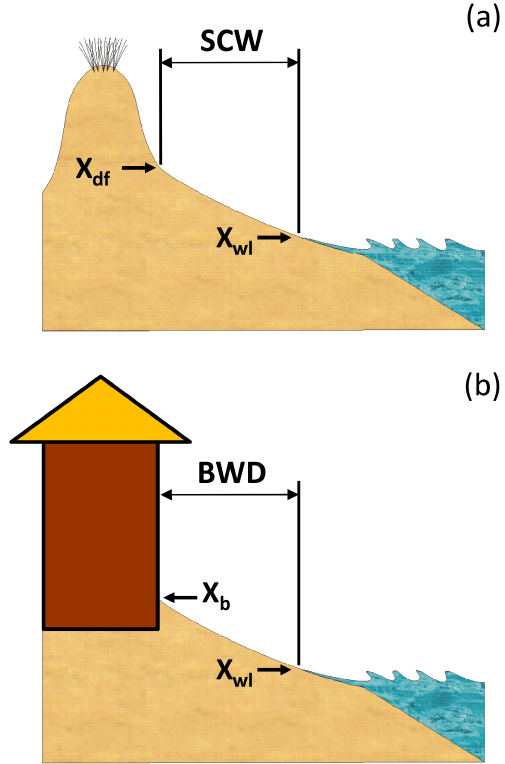
Figure 3. The two storm impact indicators (SIIs) used to trans- late XBeach model output into a format useful for decision mak- ers. (a) The safe corridor width (SCW). (b) The building–waterline distance